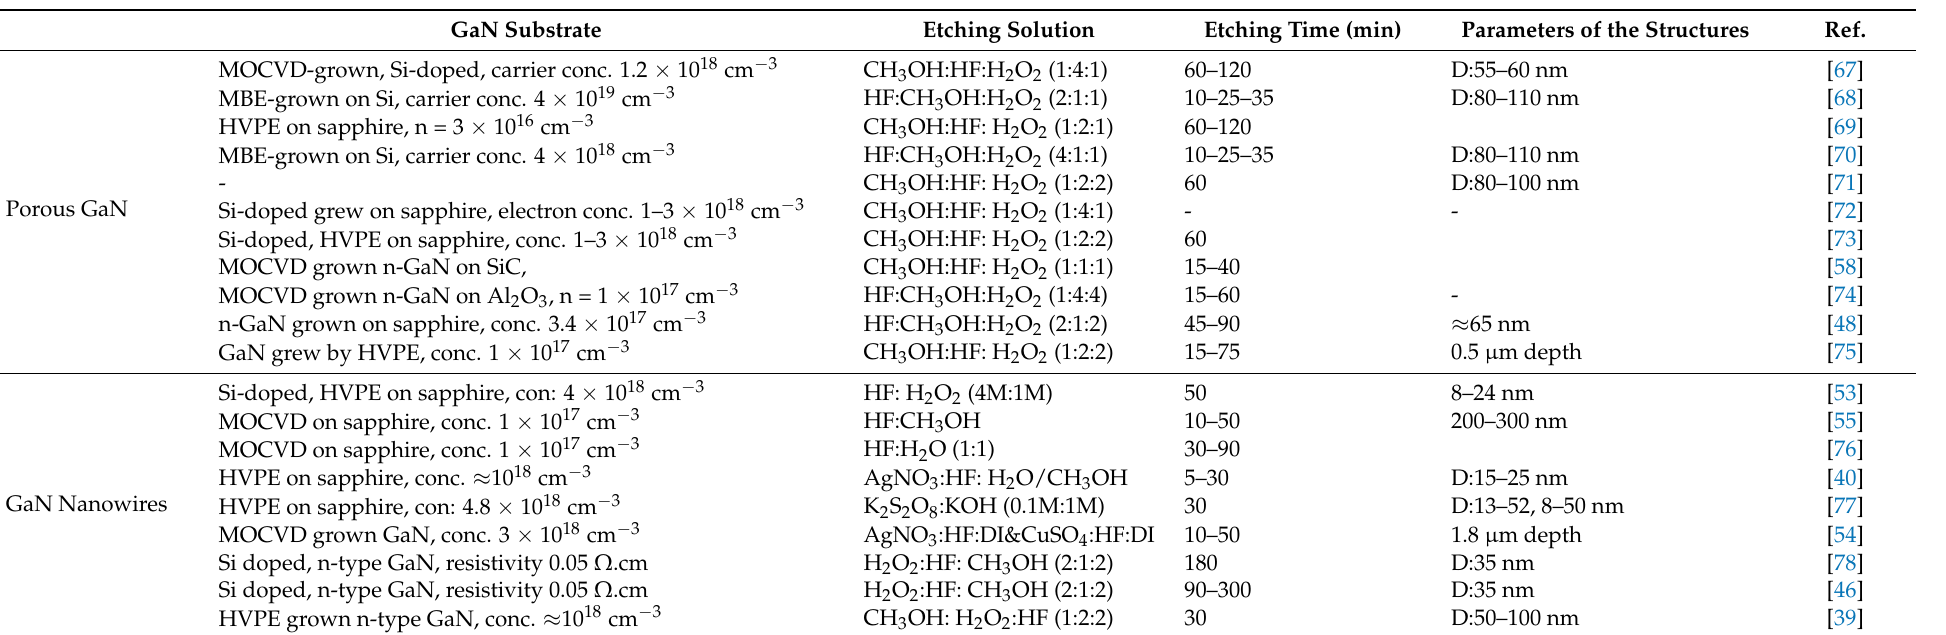
Table 1. Parameters for the formation of porous GaN and GaN nanowires via metal electroless etching. GaN Substrate Etching Solution Etching Time (min) Parameters of the Structures